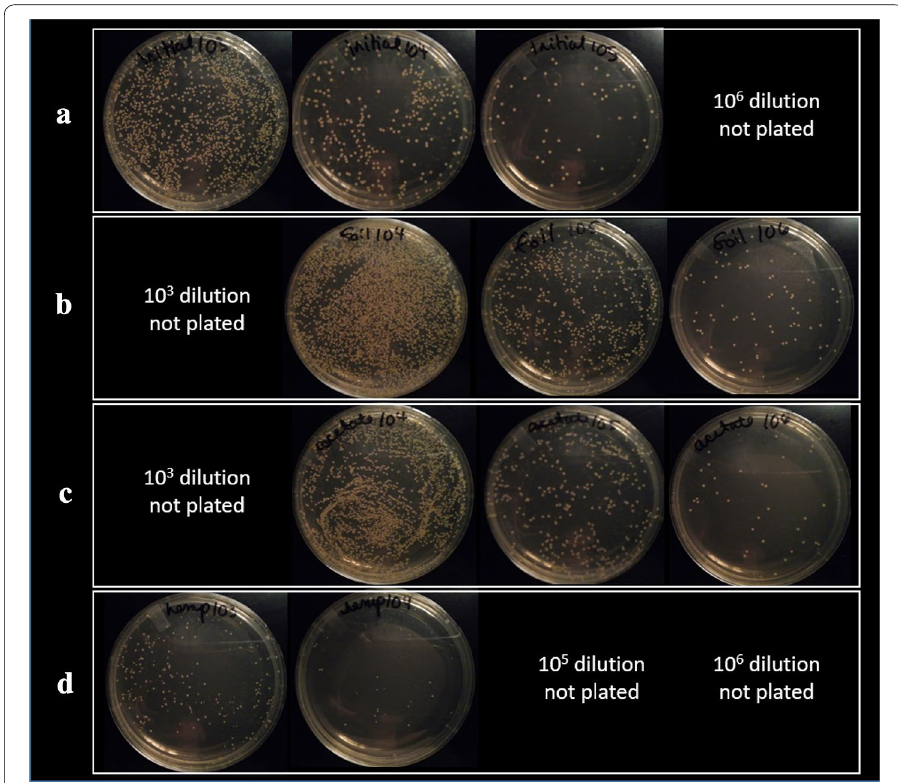
Fig. 3 Representative images of S. aureus colonies growing on TSA plates. The load of viable bacteria initially applied to the samples, as well as recovered from the samples, was quantitated based upon the number of bacterial colonies growing on TSA plates after overnight incubation at 37 °C. All samples were plated in duplicate, but only one plate of each duplicate is shown for simplicity of presentation. Samples from dilutions containing bacterial loads which were too high or too low were not plated, as the plates would show nearly confluent growth or no growth. For visual comparison of relative amounts of viable bacteria applied to or recovered from samples, images are aligned vertically according to the fold of serial dilution of bacteria before plating. Digital photographs were also taken of the agar surface with the lid of the plate removed, and those images were used to count the number of colonies using the Colony Counter Plugin of ImageJ (Schneider et al. 2012). a Bacterial colonies obtained from the TSA slurry culture from which the initial load of bacteria was applied to the sample materials. Panels b , c , and d show bacterial colonies recovered from sample materials after a 4 h incubation at 37 °C. Samples are as follows: b aluminum foil backing without nanofibers; c foil‑backed 100% acetate nanofibers; d foil‑backed acetate nanofibers containing 30% full‑spectrum hemp extract. Note the large increase in bacterial growth permitted by the samples of aluminum foil without nanofibers ( b ) and samples of foil‑backed 100% acetate nanofibers ( c ), as compared to the initial load of bacteria applied ( a